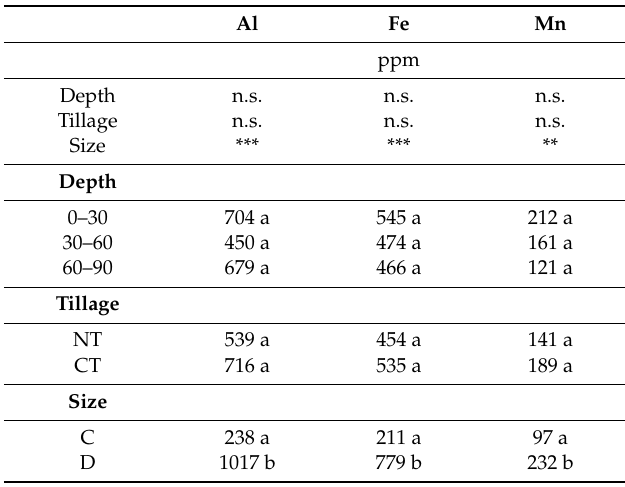
Table 3. Analysis of variance and mean values of amorphous oxides subdivided by soil depth, size fractions (C and D) and